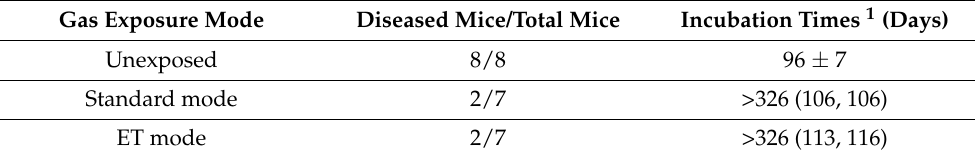
Table 1. Incubation times in Tg(MoPrP)/ Prnp 0/0 mice intracerebrally implanted with RML prion- contaminated stainless steel wires exposed to ozone gas mixed with vaporized hydrogen peroxide